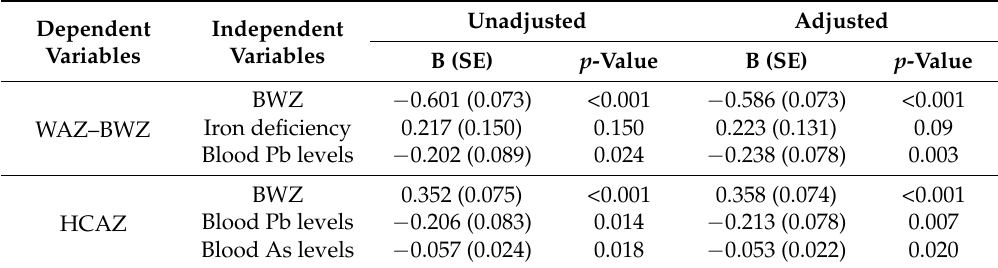
Table 3. Adjusted linear regression models for growth parameters in 210 infants according to possible growth-related factors including toxic metal